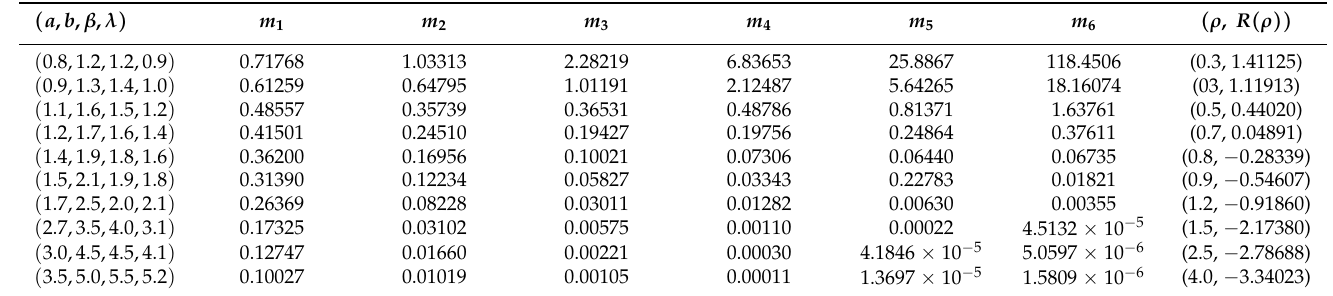
Table 2. Some possible numerical values of the first six moments and Rényi entropy of the NEKwE distribution for some parameter values.